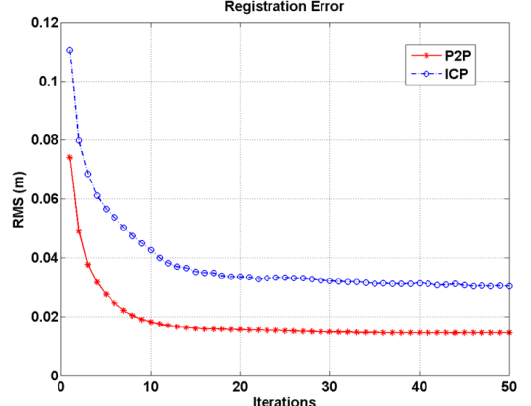
Figure 2: Incidence Angles for Buddha data, (a) Left View, (b) Right View.